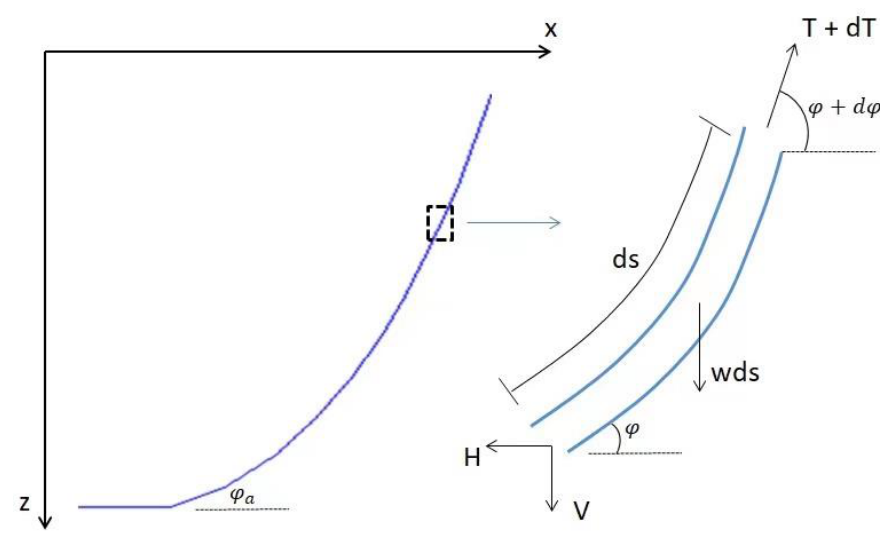
Figure 3. Free body diagram of a mooring cable segment.